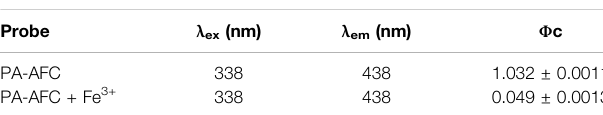
TABLE 2 | Fluorescence quantum yield.